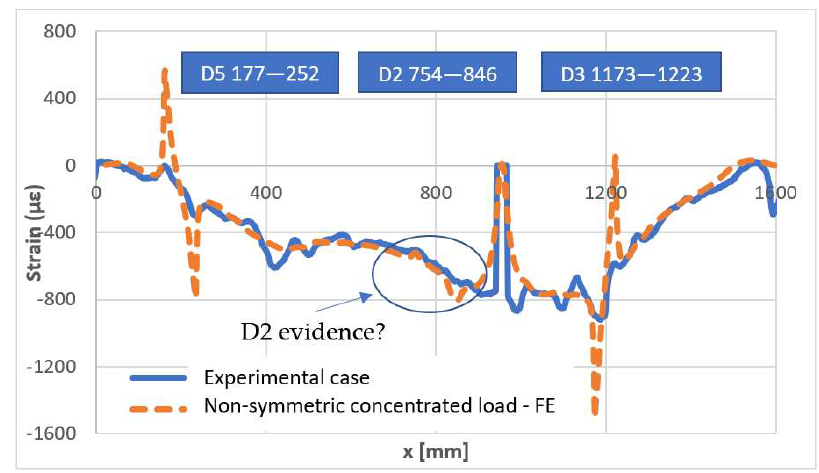
Figure 38. Numerical–experimental correlation—non-symmetric load.